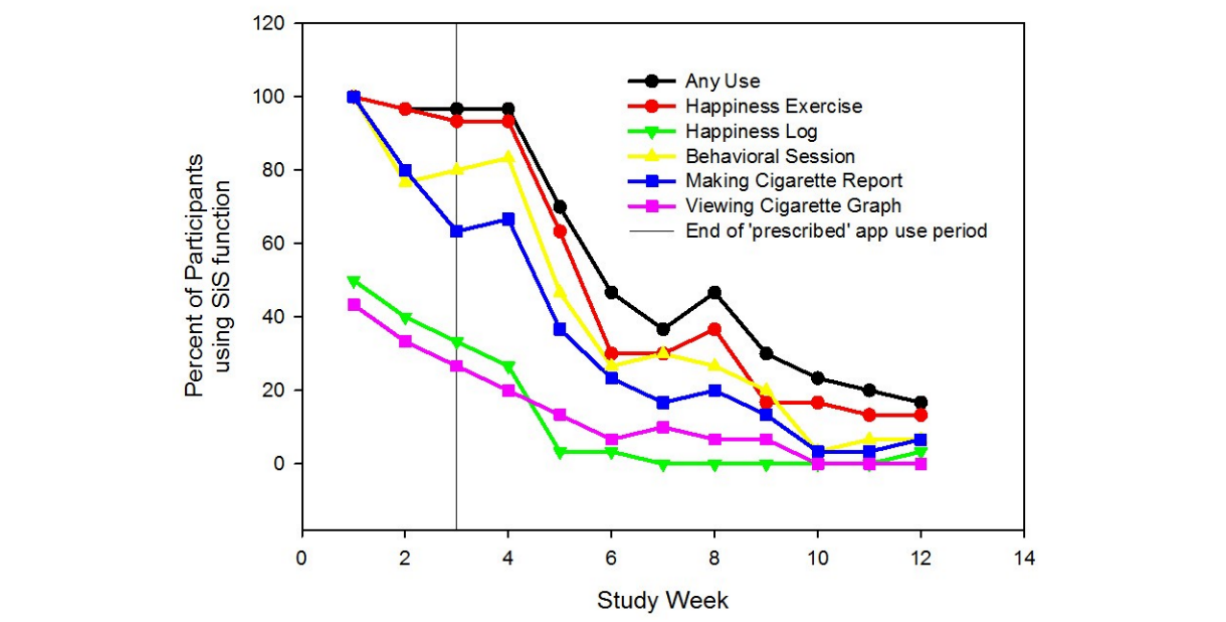
Figure 3. App usage per study week. SiS: Smiling Instead of Smoking.